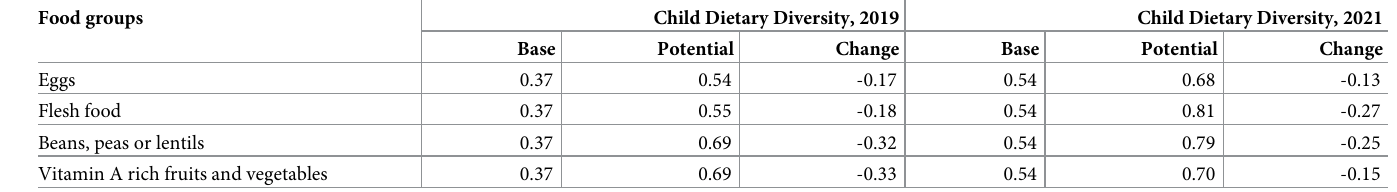
Table 6. PAR analysis based potential dietary diversity (%) achievable among children (6–23 months) through planning a universal coverage of selected food groups, Gadchiroli and Chandrapur, 2019 and 2021. Food